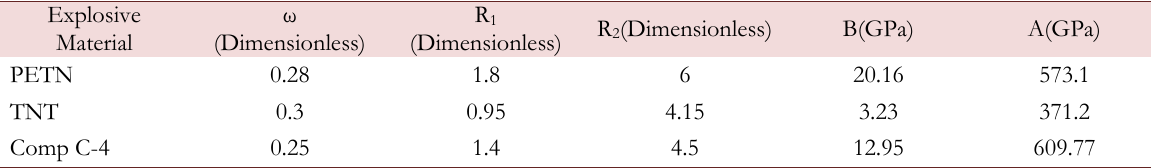
Table 1: JWL Equation of state parameters for several explosive materials